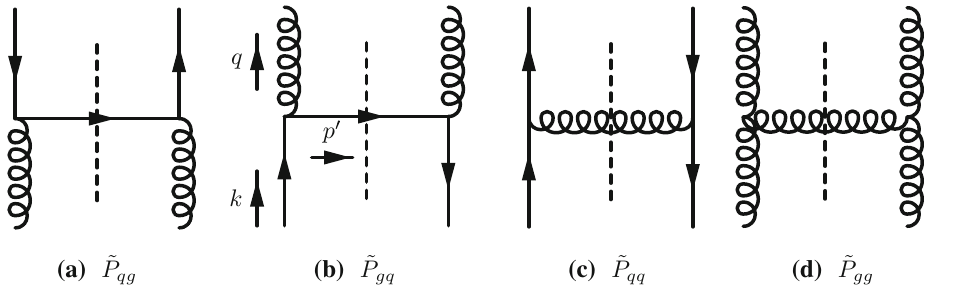
Fig. 1 Squared matrix elements for the determination of the real contributions to the splitting functions à-la Curci-Furmanski-Petronzio. Lower (incoming) lines carry always momentum k , upper (outgoing) lines carry momentum